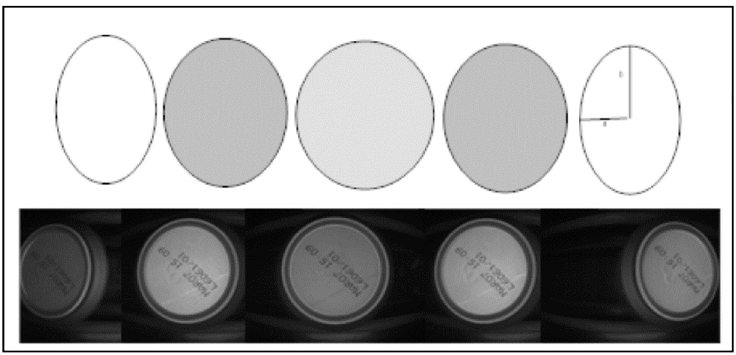
Figure 2. Selection of the best snapshot for a can. The best snapshot is the one where the can appears